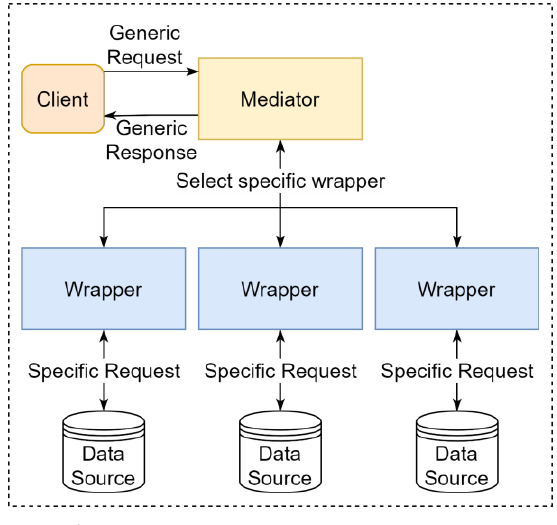
Figure 2 . General mediator-wrapper architecture